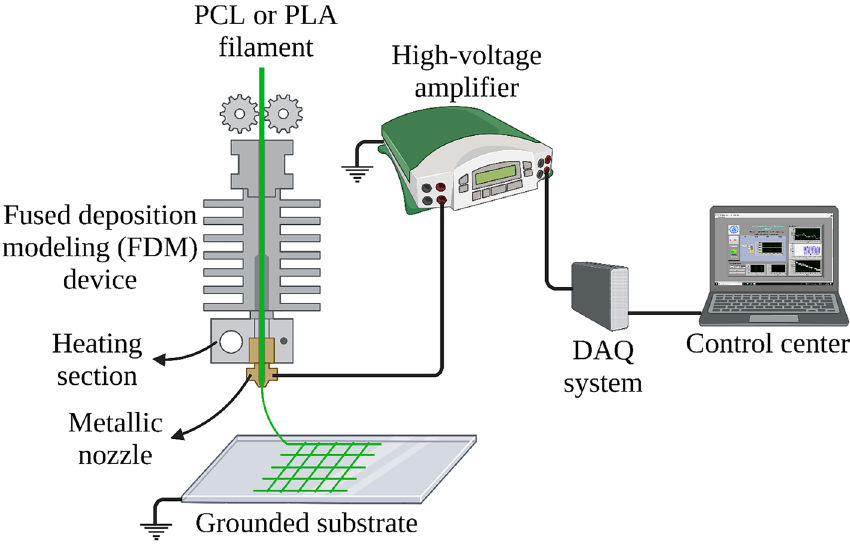
Figure 1. Schematic of the experimental setup (drawn on the BioRender website (https:// biore nder. com) by the